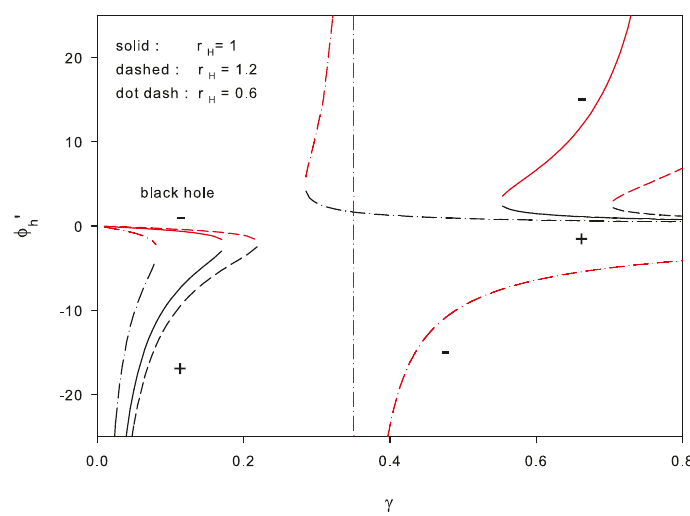
Figure 3 . We show the domain of existence of black hole solutions with scalar hair and (cid:3) = (cid:0) 3 in the (cid:30) 0 { (cid:13) { plane. The curves denote the critical value of (cid:13) (see (4.9)) for the four di(cid:11)erent branches h (see also (4.7)) for r h = 1 : 2 (dashed), r h = 1 : 0 (solid) and r h = 0 : 6 (dotted-dashed). Note that the + and (cid:0) indicate the two di(cid:11)erent branches as given by (4.7). Moreover, the vertical dotted-dashed line is the value of (cid:13) at which the denominator of (4.7) becomes zero for r h = 0 :